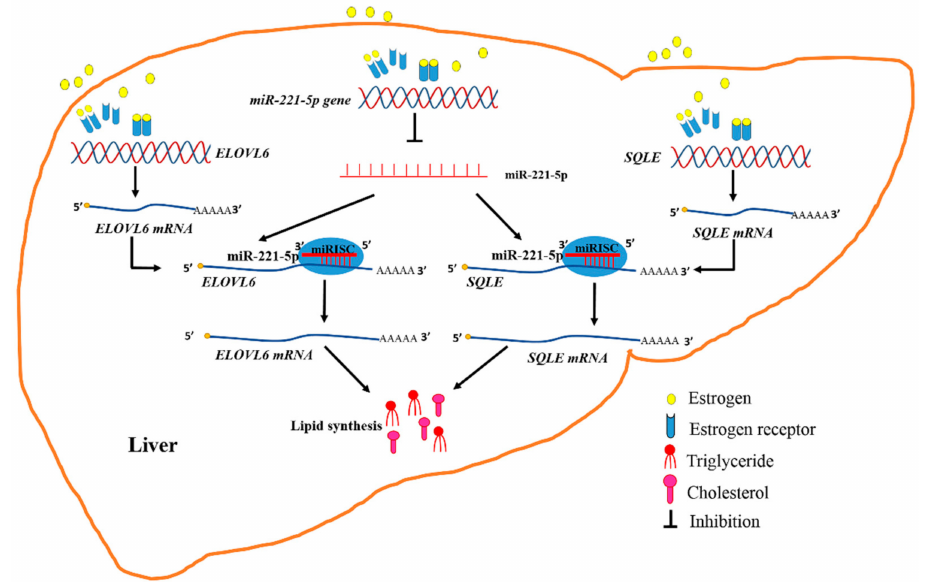
Figure 10. Diagram illustrating the underlying mechanism by which that estrogen and miR-221-5p target ELOVL6 and SQLE to participate in chicken liver lipid